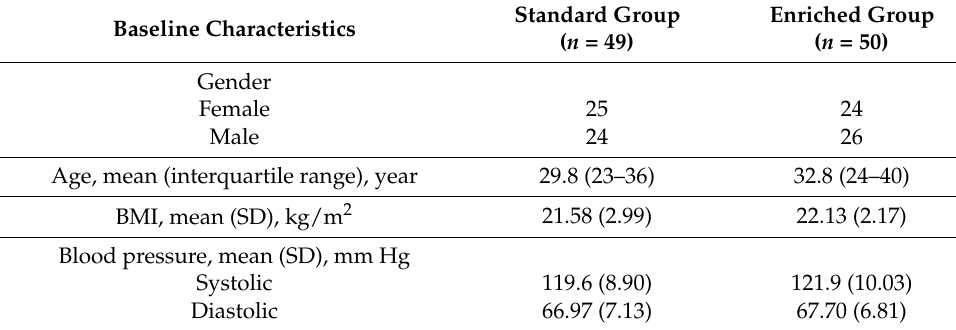
Table 2. Baseline characteristics of the